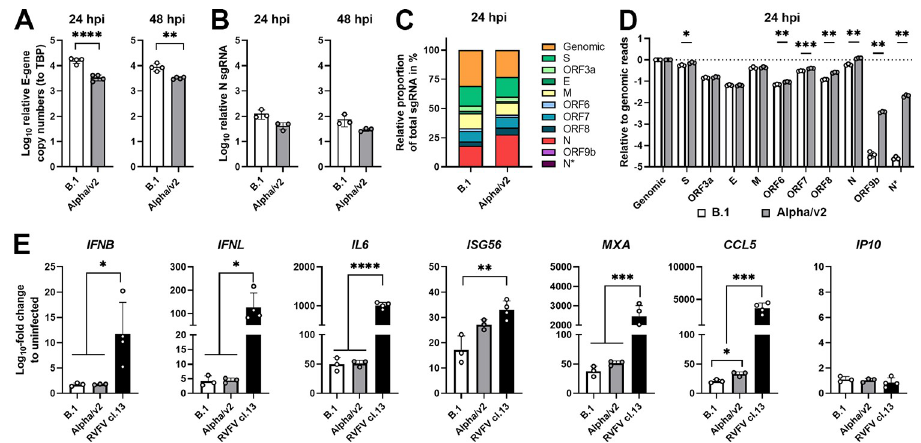
Fig 3. VOC Alpha and B.1 share efficient prevention of induction of innate immunity despite VOC Alpha-specific enhanced production of viral subgenomic RNA transcripts. Calu-3 cells were infected with B.1 or VOC Alpha (MOI of 2) and cell lysates were generated either 24 or 48 hours postinfection, following total RNA extraction. Samples were generated in 4 individual experiments each conducted in quadruplicates. ( A ) Expression of cell-associated envelope was determined in Calu-3 at 24 and 48 hours postinfection by Q-RT-PCR. TBP was used for normalization. ( B ) Expression of cell-associated sgN in Calu-3 cells at 24 and 48 hours postinfection was determined by Q-RT-PCR. TBP was used for normalization. ( C ) RNA-seq analysis was conducted from total cell lysates that were obtained 24 hours postinfection to quantify sgRNA proportions in infected cells. Stacked bars depict the relative proportion of total sgRNA in Calu-3 cells mapping to each viral sgRNA from the RNA-seq dataset. ( D ) Canonical, as well as ORF9b and N � sgRNAs were quantified from the RNA-seq dataset. Data were normalized to the respective B.1- or VOC Alpha- specific genomic reads. ( E ) Expression of the indicated genes was determined by Q-RT-PCR. Shown is the mean fold change +/ − SD. RVFV cl.13, which is devoid of its IFN antagonist NSs, was included as an induction control for the expression of IFNs and ISGs . IFN, interferon; MOI, multiplicity of infection; Q-RT-PCR, quantitative real-time PCR; RVFV cl.13, Rift Valley Fever Virus clone 13; sgN, subgenomic nucleocapsid; sgRNA, subgenomic RNA; TBP, TATA- binding protein; VOC, variant of concern. See S1